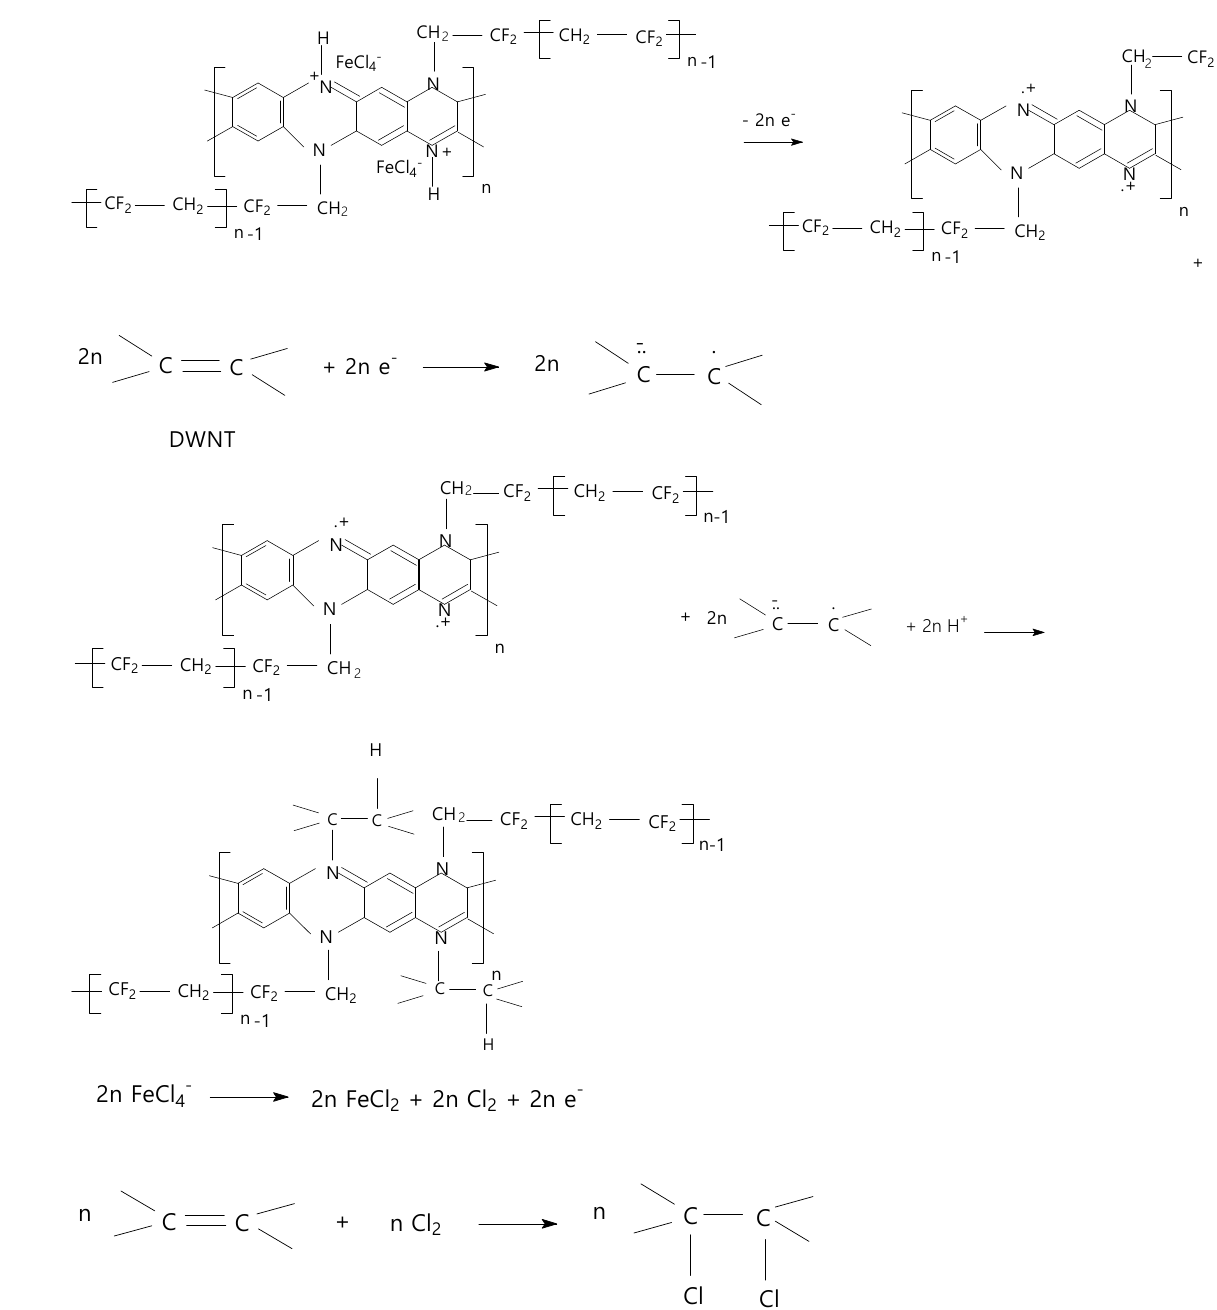
Scheme 3. The chemical mechanism of the interaction of POPD doped with FeCl 4 - ions with